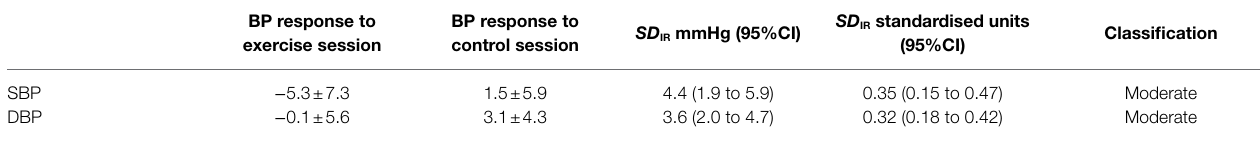
TABLE 2 | Quantification of the interindividual variation of post-dynamic resistance exercise